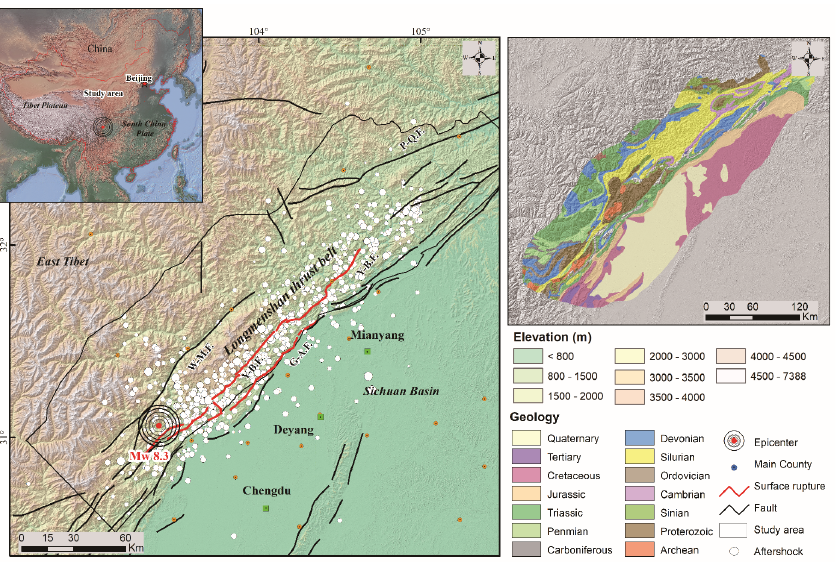
Figure 3. Map of the affected area of the Wenchuan earthquake that is used for model validation. Geology map is collected from China geological survey.